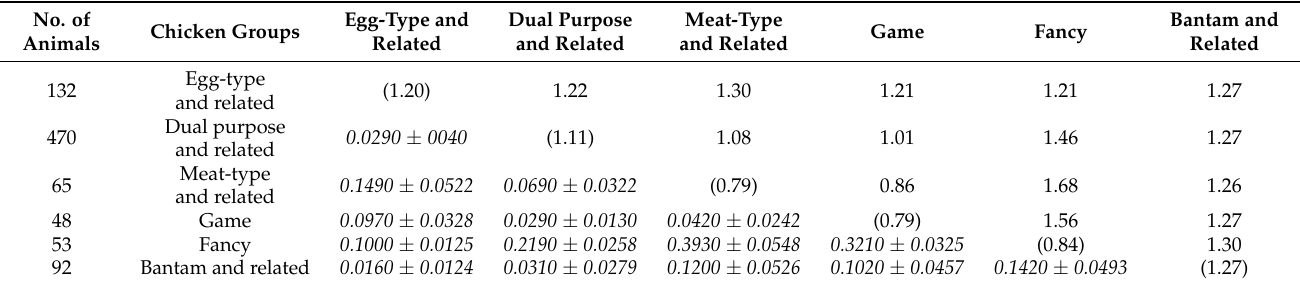
Table 2. Pairwise D and F ST values 1 based on allele frequencies in the five SNPs at the NCAPG-LCORL locus among the studied chicken breeds/populations grouped by differences in phenotypic traits (according to PCM that involves six clusters as in Figure 1a,b).